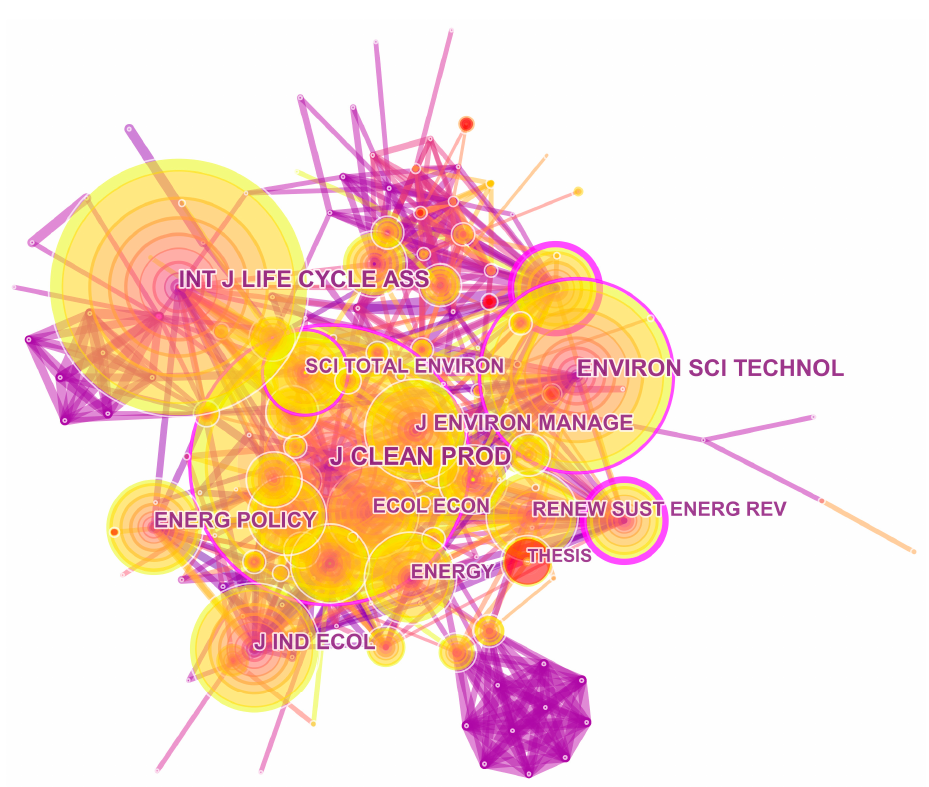
Figure A1. Author co-citation network.